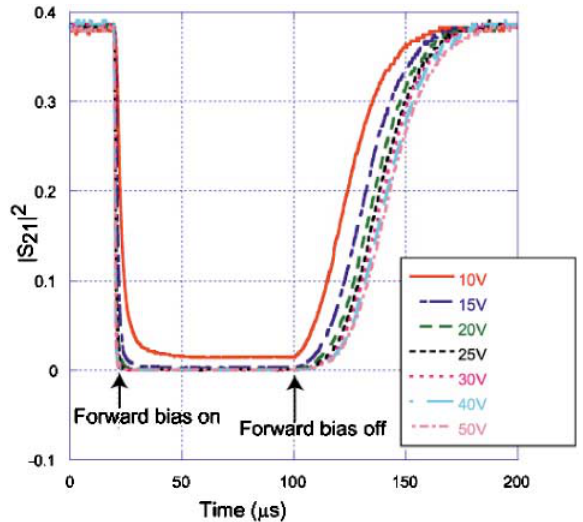
FIG. 16. (Color) Typical waveform of transmission with various forward biases.